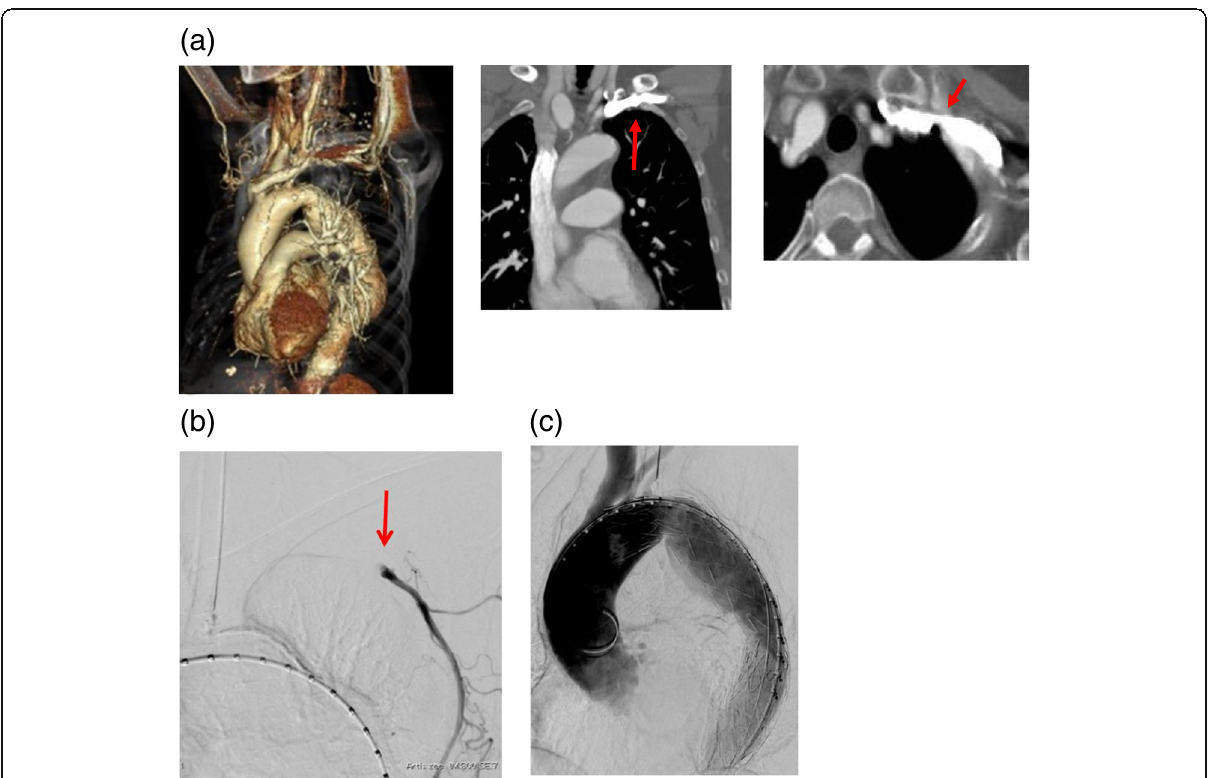
Fig. 2 a Preoperative enhanced CT scan failed to visualize AAO. (Left innominate vein ’ s enhancement concealed the presence of AAO.) Contrast was injected from the left upper extremity, and this caused severe halation. b The AAO was encountered during LSCA angiography (arrow). c There were no endoleaks on completion